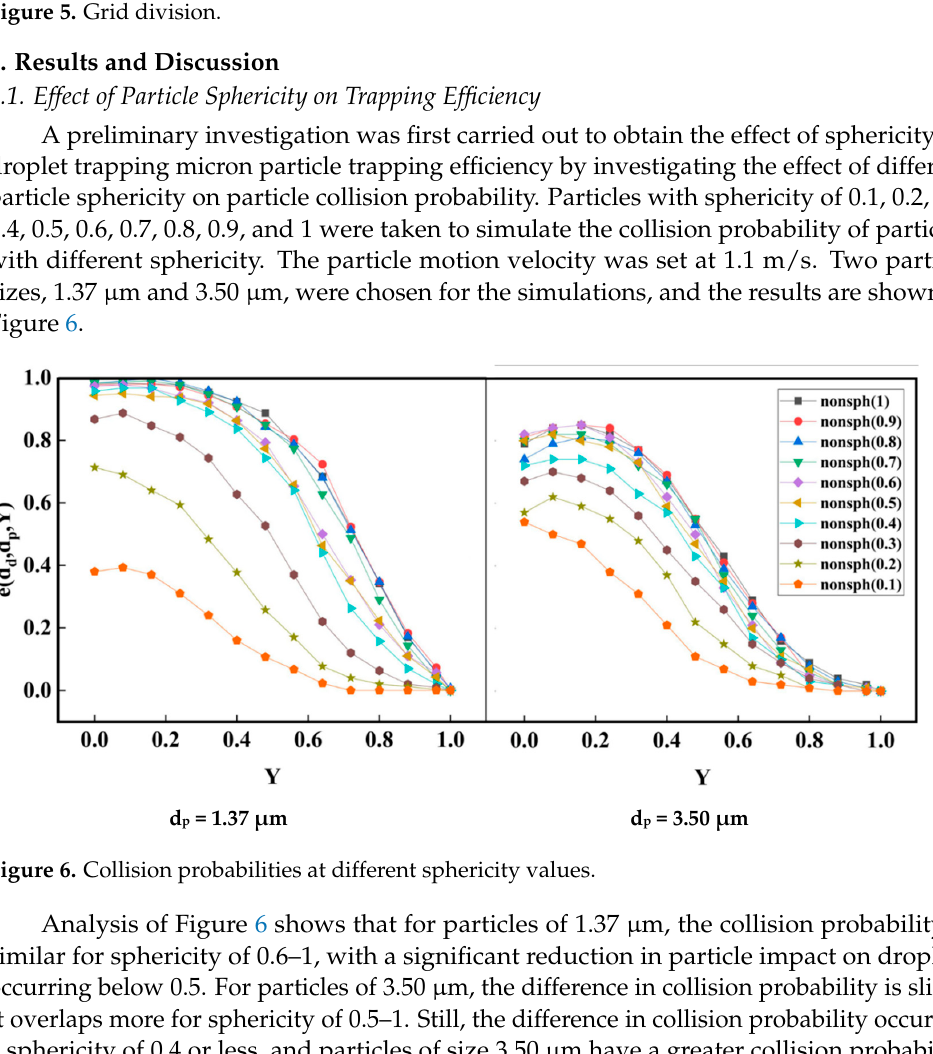
Figure 5. Grid division.